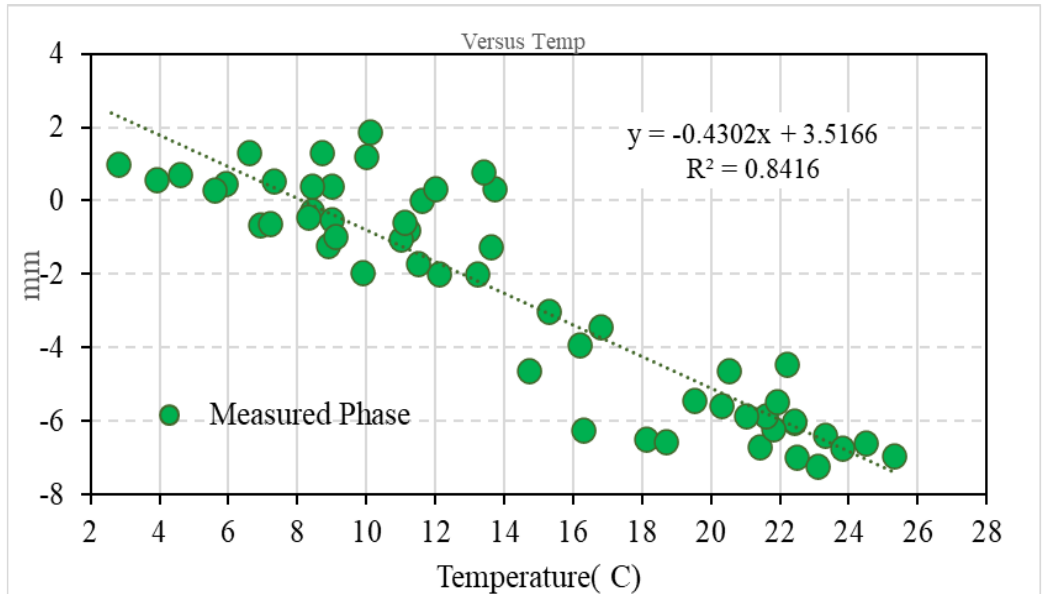
Figure 7. Plot of the deformation, vertical axis in [mm], versus temperature.